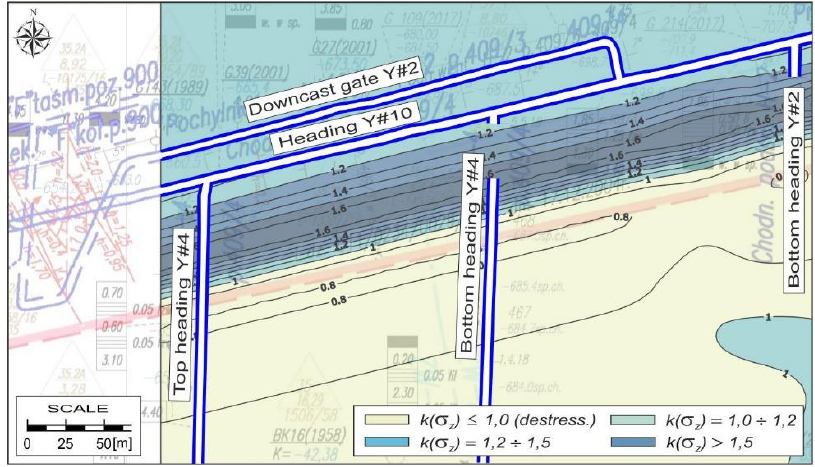
Figure 9. Stress concentration factor ( k ) in the coal seam (a section of panel Y).